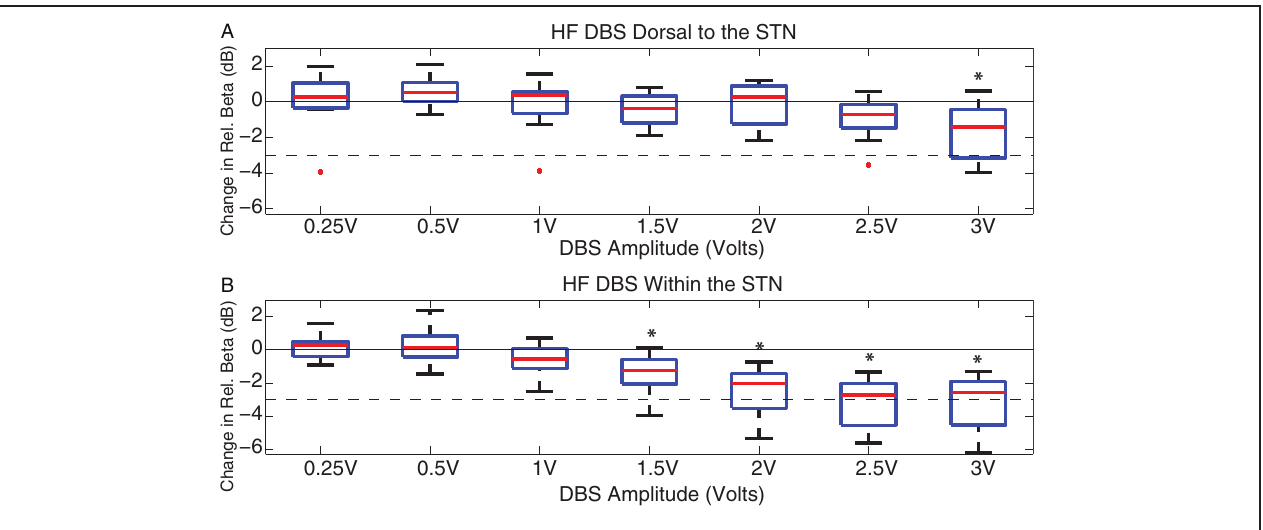
baseline beta ratio. The 10log 10 power ratio was computed, such that all cases can be compared on a decibel scale. ∗ Indicate a significant difference from baseline with overall p < 0 . 05 (ANOVA with Holm–Sidak correction). The 50% attenuation level is marked with a dashed line, represented at − 3dB.